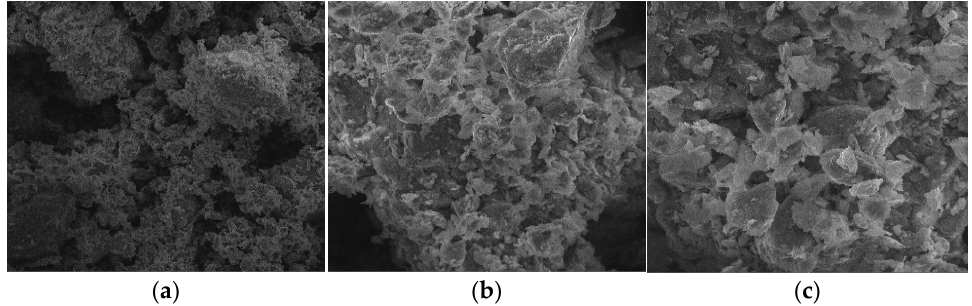
Figure 6. SEM of activated carbon pellets (MAG: 838× ( a ); MAG: 3.33 k× ( b ); MAG: 6.67 k× ( c )).